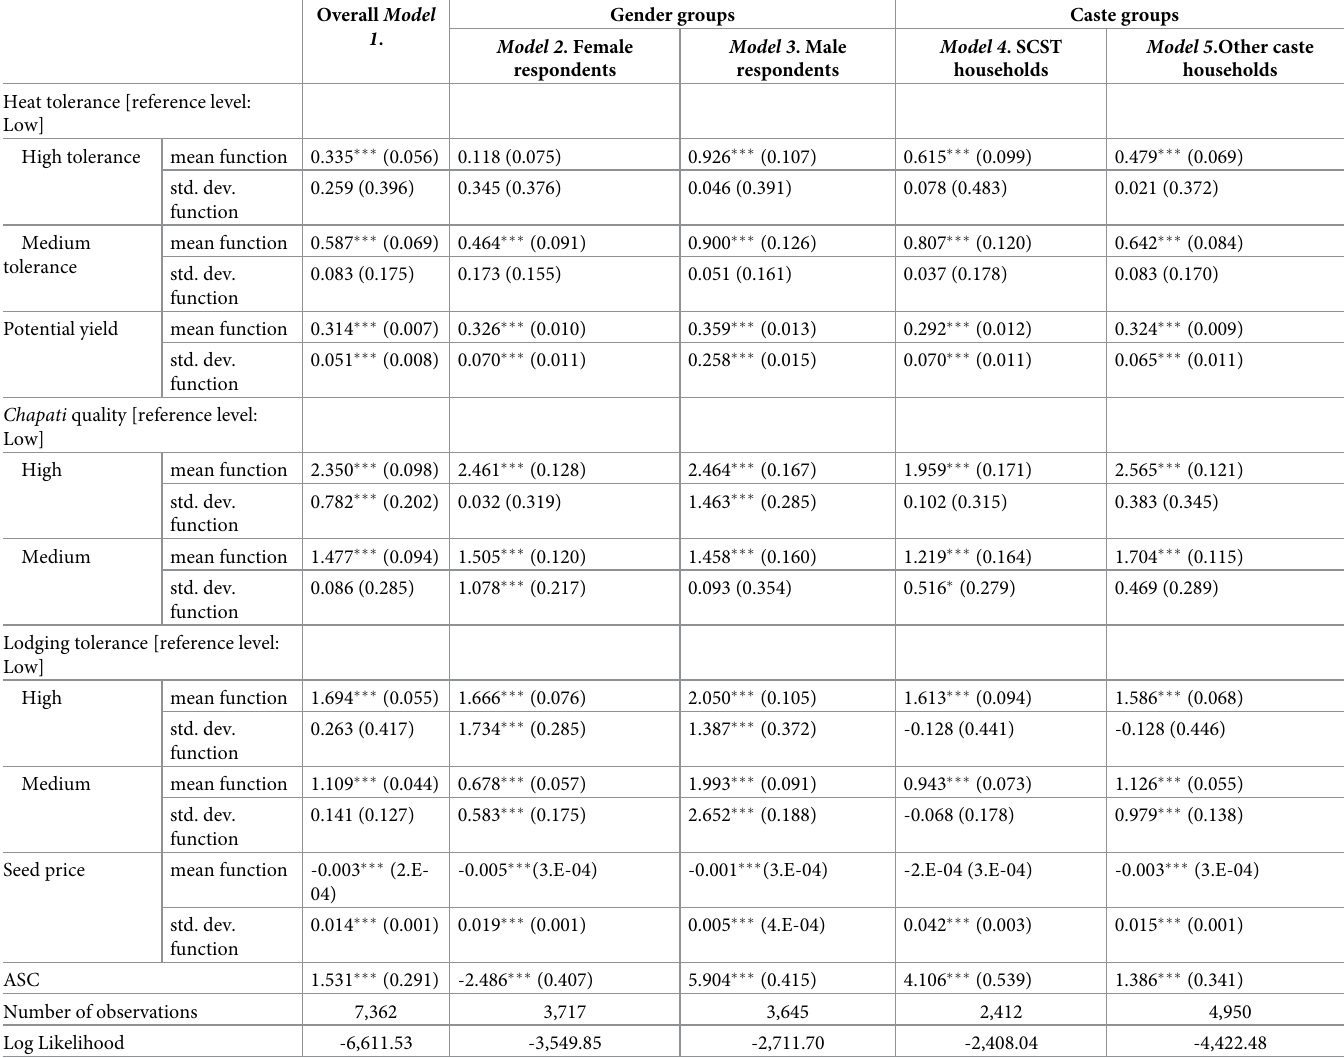
Table 5. Mixed logit model estimates on farmer preferences for varietal